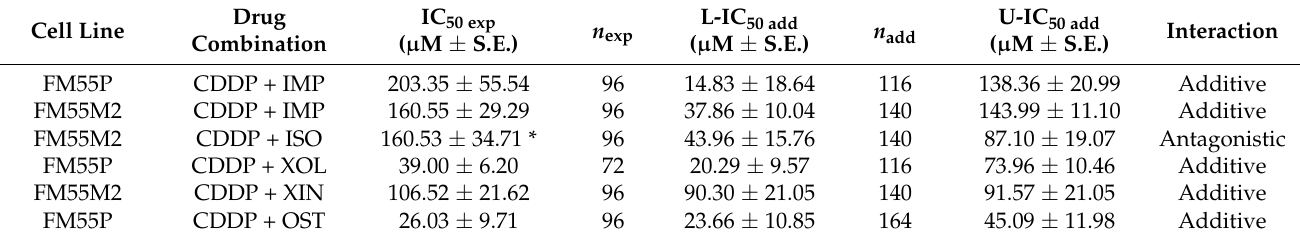
Table 3. Isobolographic analysis of interactions for nonparallel concentration–response effects in melanoma cell lines. Cell Line